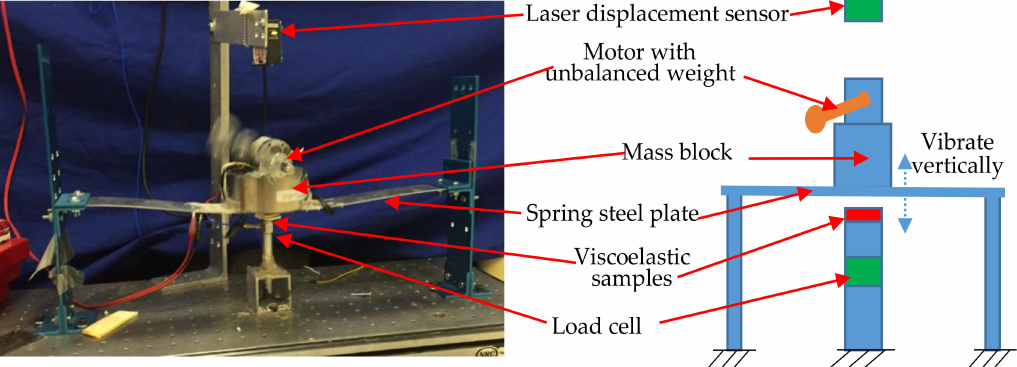
Figure 3. Experimental